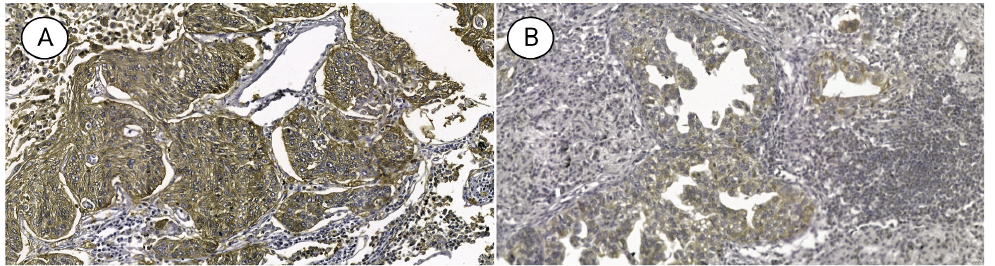
Figure 1. Micrograph of non ‐ small cell lung cancer ‐ expressing ( A ) GLUT1 and ( B ) GLUT3 (×400).